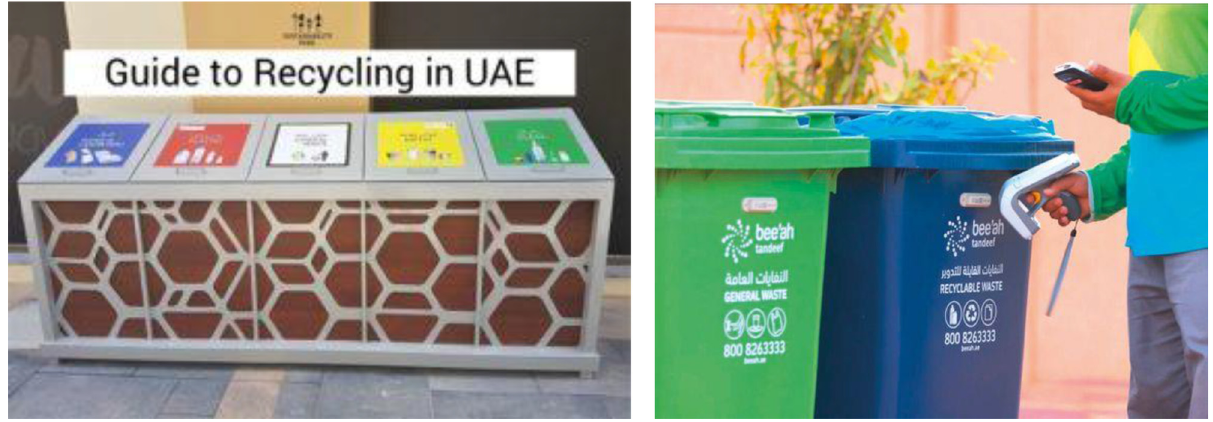
Fig. 5. Recycling guides and bins